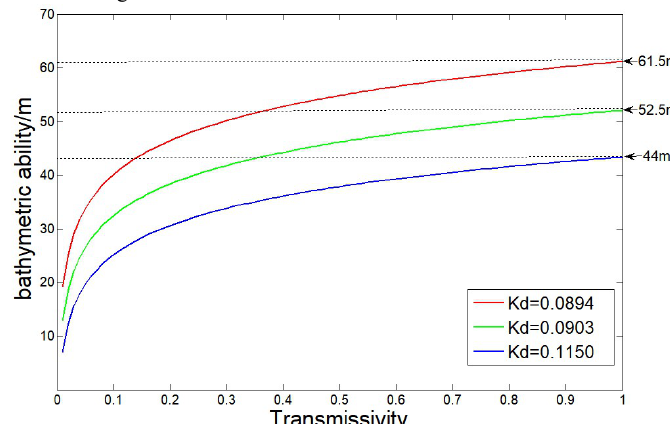
Fig 6 Transmissivity simulation under Mie scattering ratio From the simulation results of the transmissivity of 1% and Fig 7 Response chart of measured depth with